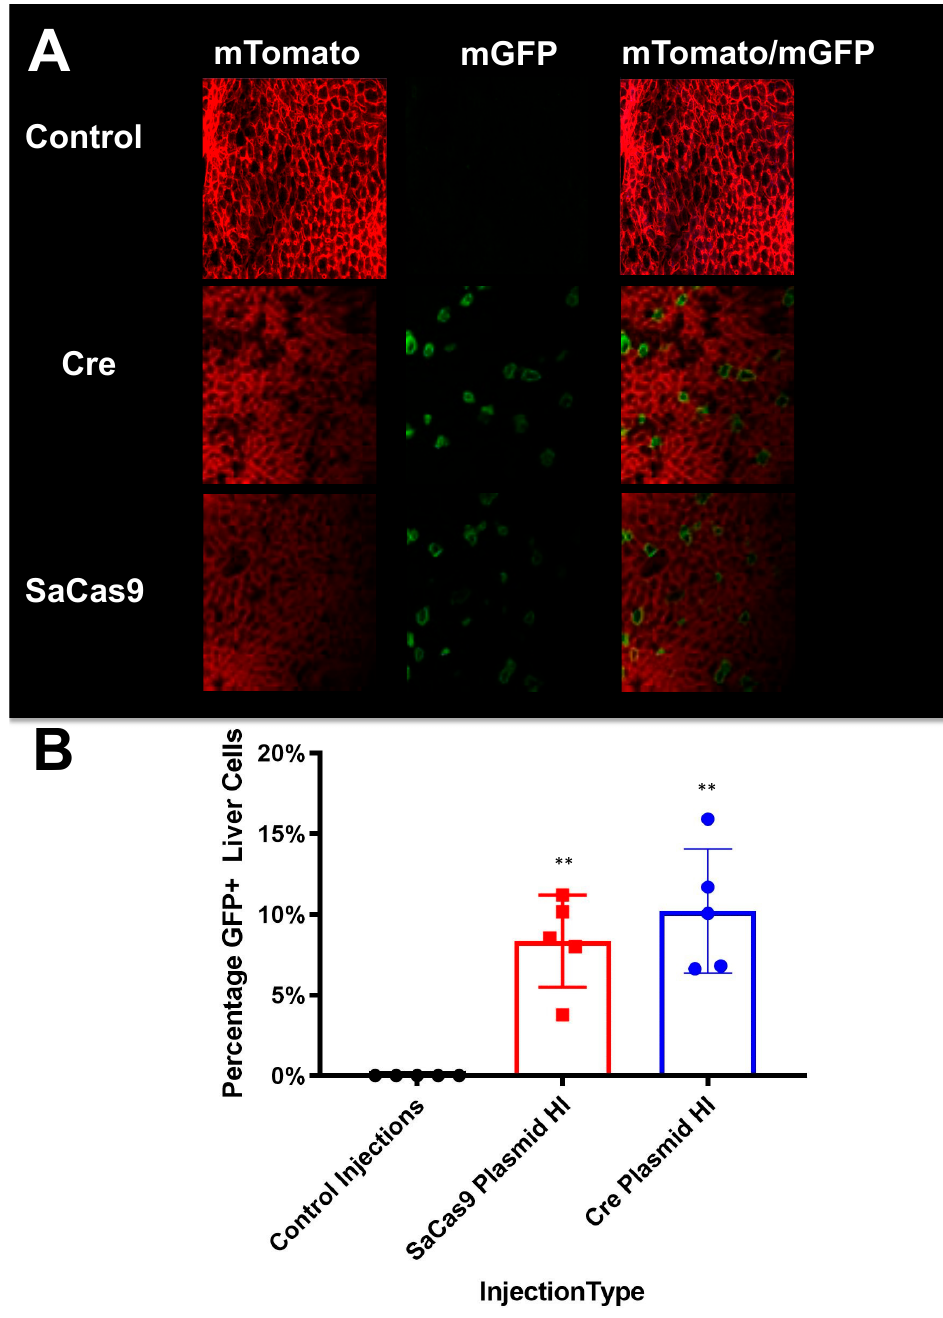
Figure 6. Liver sectioning from hybrid mice. ( A ) Mouse livers were harvested, fixed, and imaged for tdTomato and GFP activity. Representative microscopy shows cre- and SaCas9-treated mouse livers. ( B ) Converted cells were counted as a percentage of total cells in representative images across the gene-edited mice. The bars are 95% confidence intervals and were found significant compared to the control by one-way ANOVA and Tukey’s multiple comparisons. The edited groups were not significant compared to each other (n = 5) (** p < 0.005).